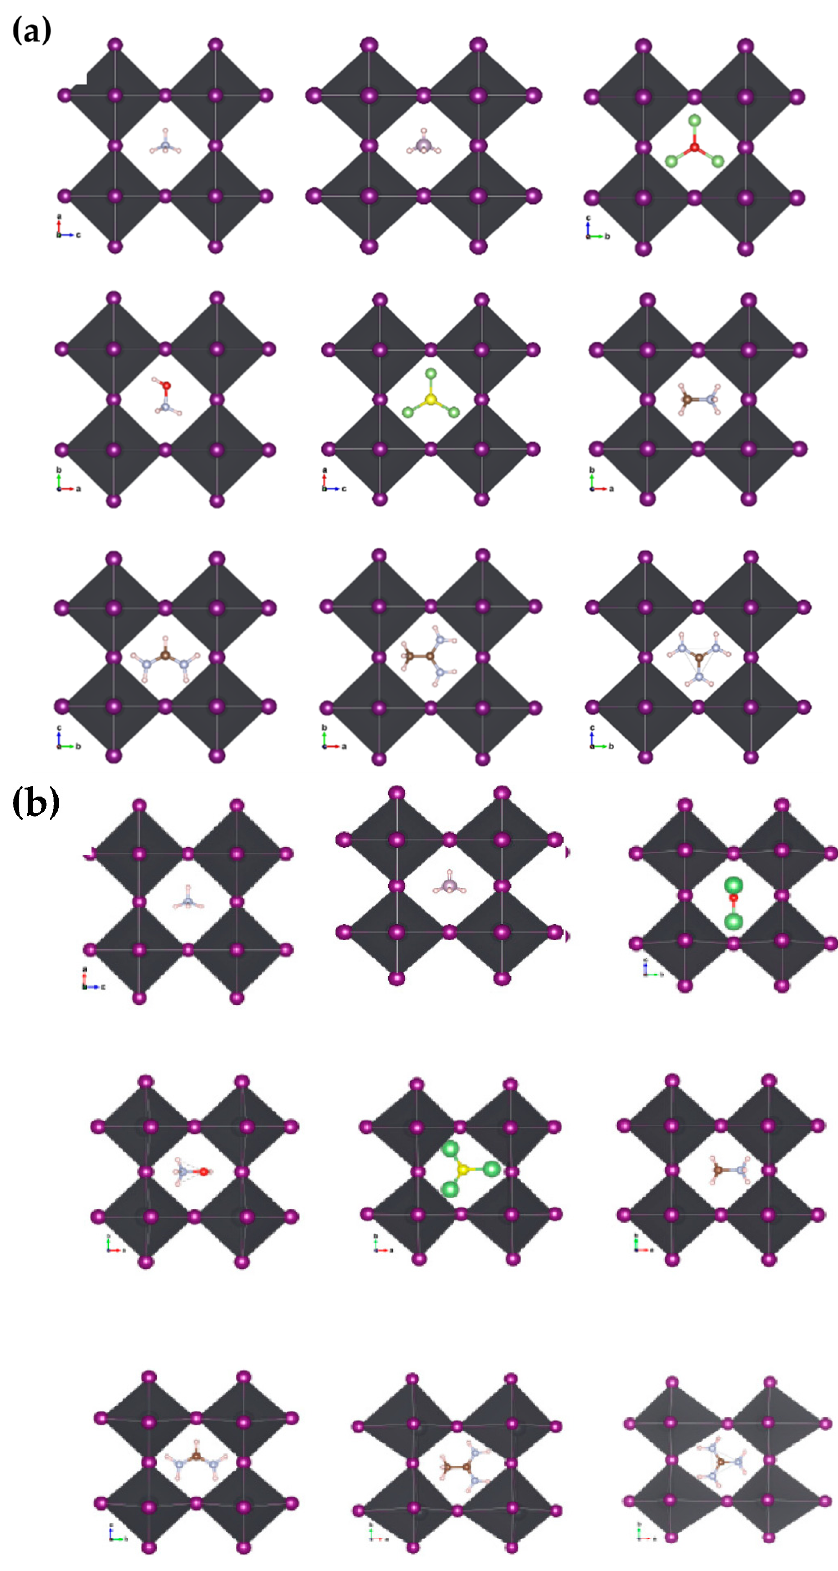
Figure 3. Geometric structures of A i PbI 3 with different cation: ( a ) before optimization; and ( b ) after optimization with Van der Waals correlation.